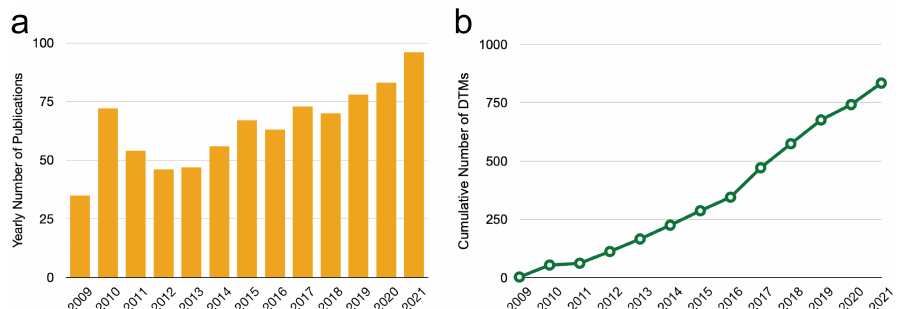
Figure 18. ( a ) Estimated number of refereed articles per year that use HiRISE DTMs based on a full text query of the Astrophysics Data System (https://ui.adsabs.harvard.edu, accessed on 10 March 2022). ( b ) Cumulative number of HiRISE DTMs in the PDS per